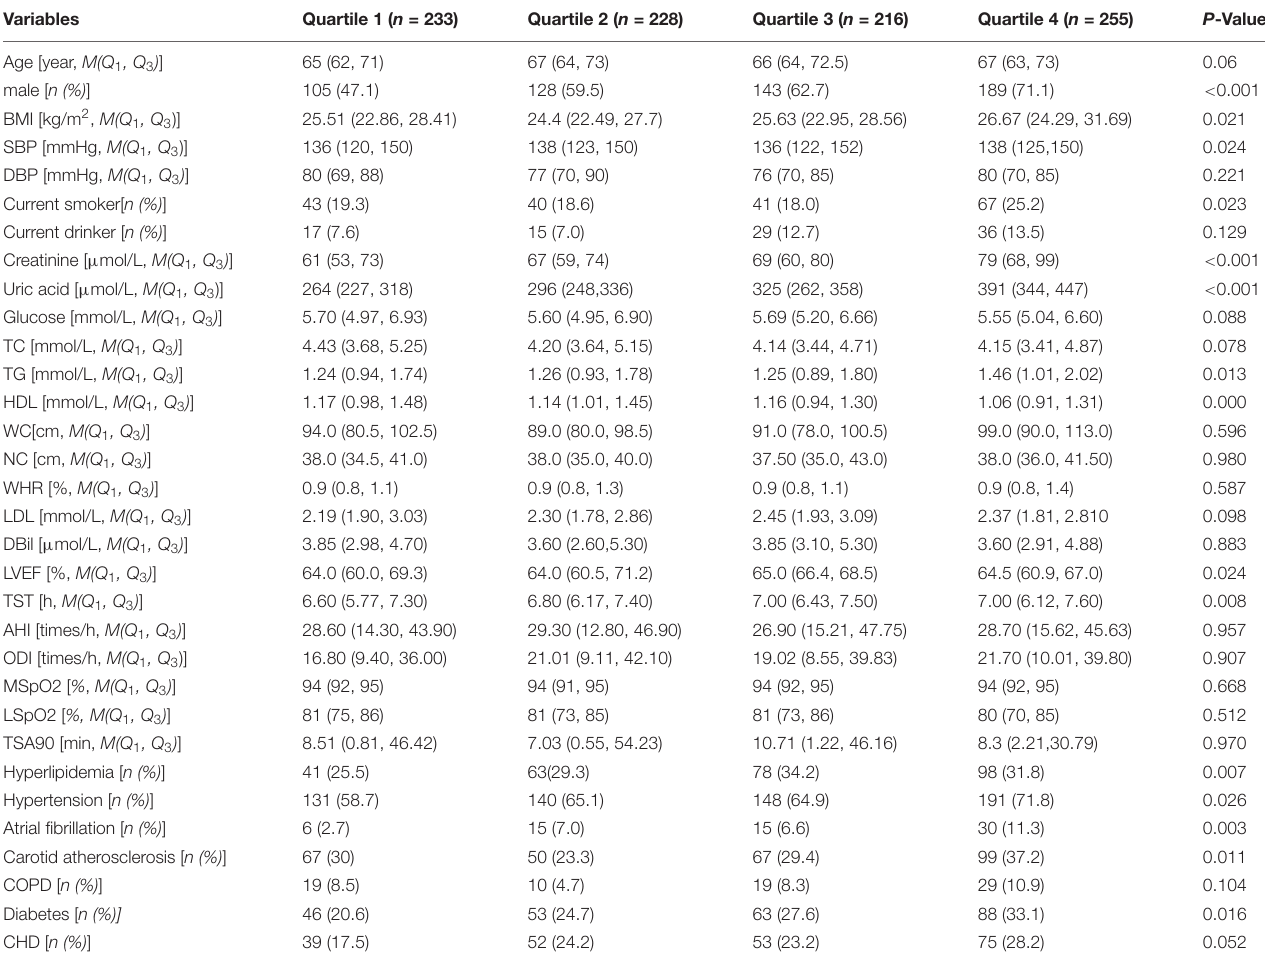
TABLE 1 | Characteristics of elderly OSA participants by Cys-C stratum.